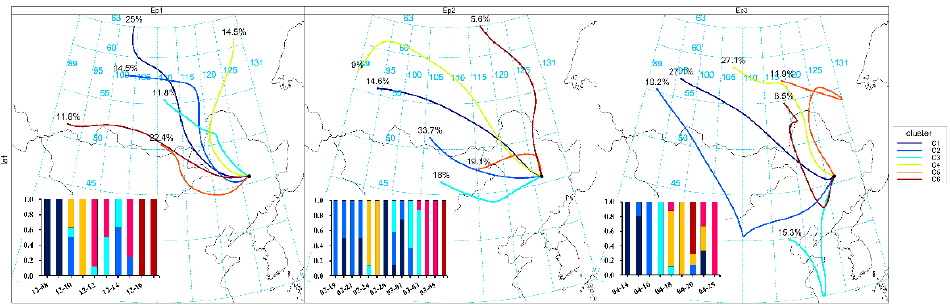
Figure 9. Potential source contribution factor weights (PSCF) and concentration weighted trajectory (CWT) results of PM 2.5 , PM 10 and SO 2 in Ep1, Ep2 and Ep3.